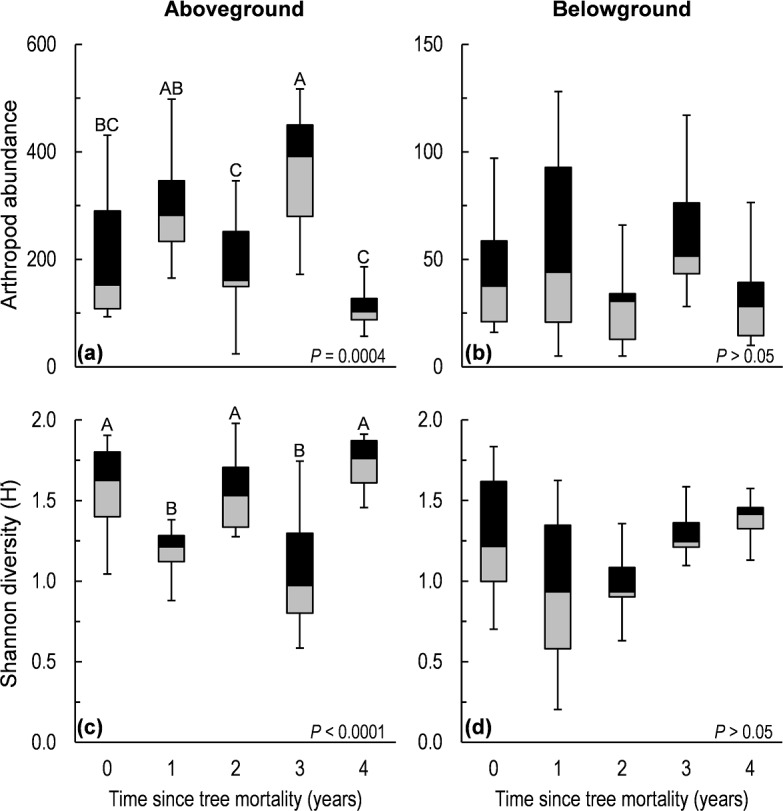
Abundance and Shannon diversity (H′) of aboveground and belowground arthropod communities sampled along a five-year chronosequence of insect-induced tree mortality.Box and whisker plots show the median (center line), the 1st and 3rd quartiles (shaded boxes), and the 1.5 inter-quartile range or ∼97% of variation in the untransformed data (whisker bars). Boxes with different letters are significantly different (P < 0.05) via LSD means comparisons following one-way ANOVA.